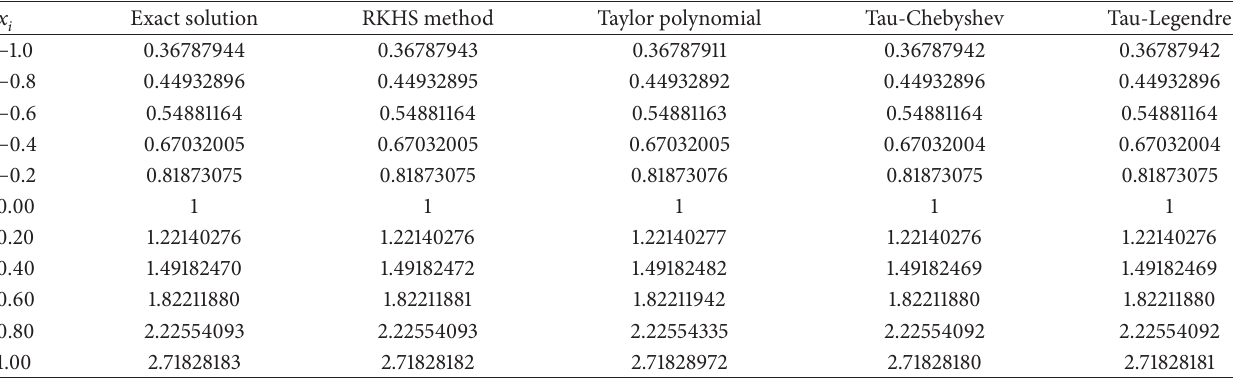
Table 1: Numerical result of Example 15 compared with the Taylor polynomial solution and Tau-Chebyshev and Legendre method. 𝑥 𝑖 Exact